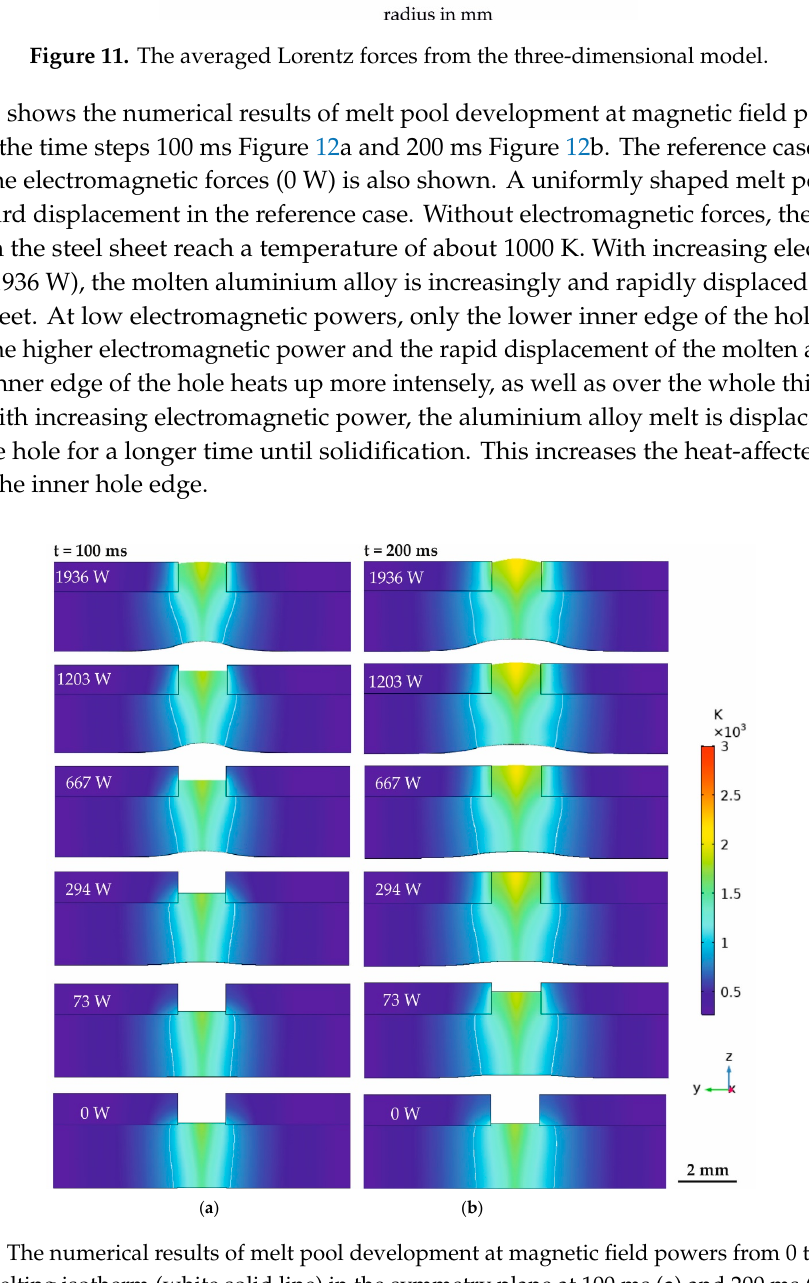
Figure 11. The averaged Lorentz forces from the three-dimensional model.